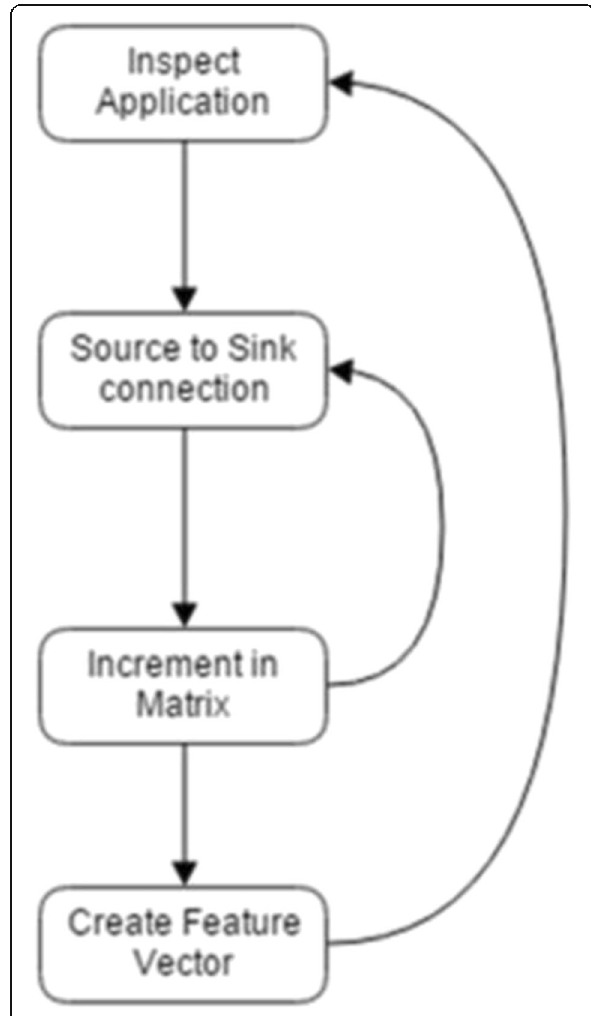
app. The process is as follows and delineated in Fig. 5. sk (cid:1) Let ( so i , t ) represent a unique source-to-sink connection or flow in app ap . For every individual connection (so , sk ) in ap , the correlating count i t